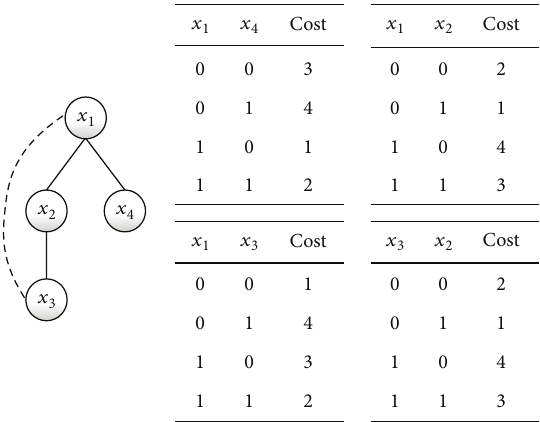
Figure 2: Completeness of initial solutions received by MUBLS and LSPA.